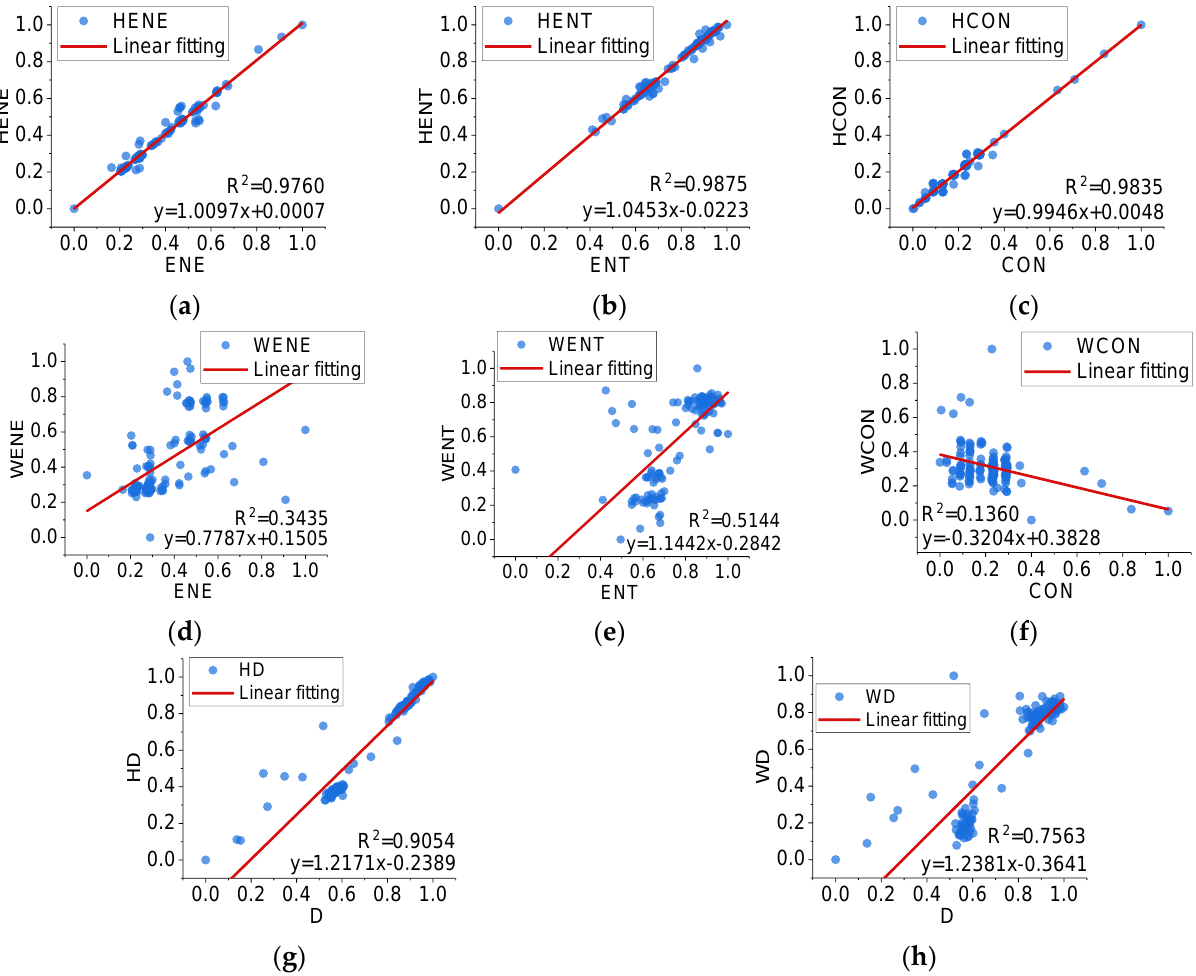
Figure 14. Linear fitting between the texture indicators before and after texture separation. ( a ) ENE and HENE . ( b ) ENT and HENT . ( c ) CON and HCON . ( d ) ENE and HENE . ( e ) ENT and HENT . ( f ) CON and HCON . ( g ) D and HD . ( h ) D and WD .